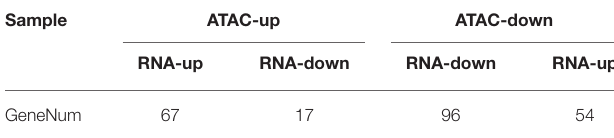
TABLE 3 | Chromatin openness of differentially expressed